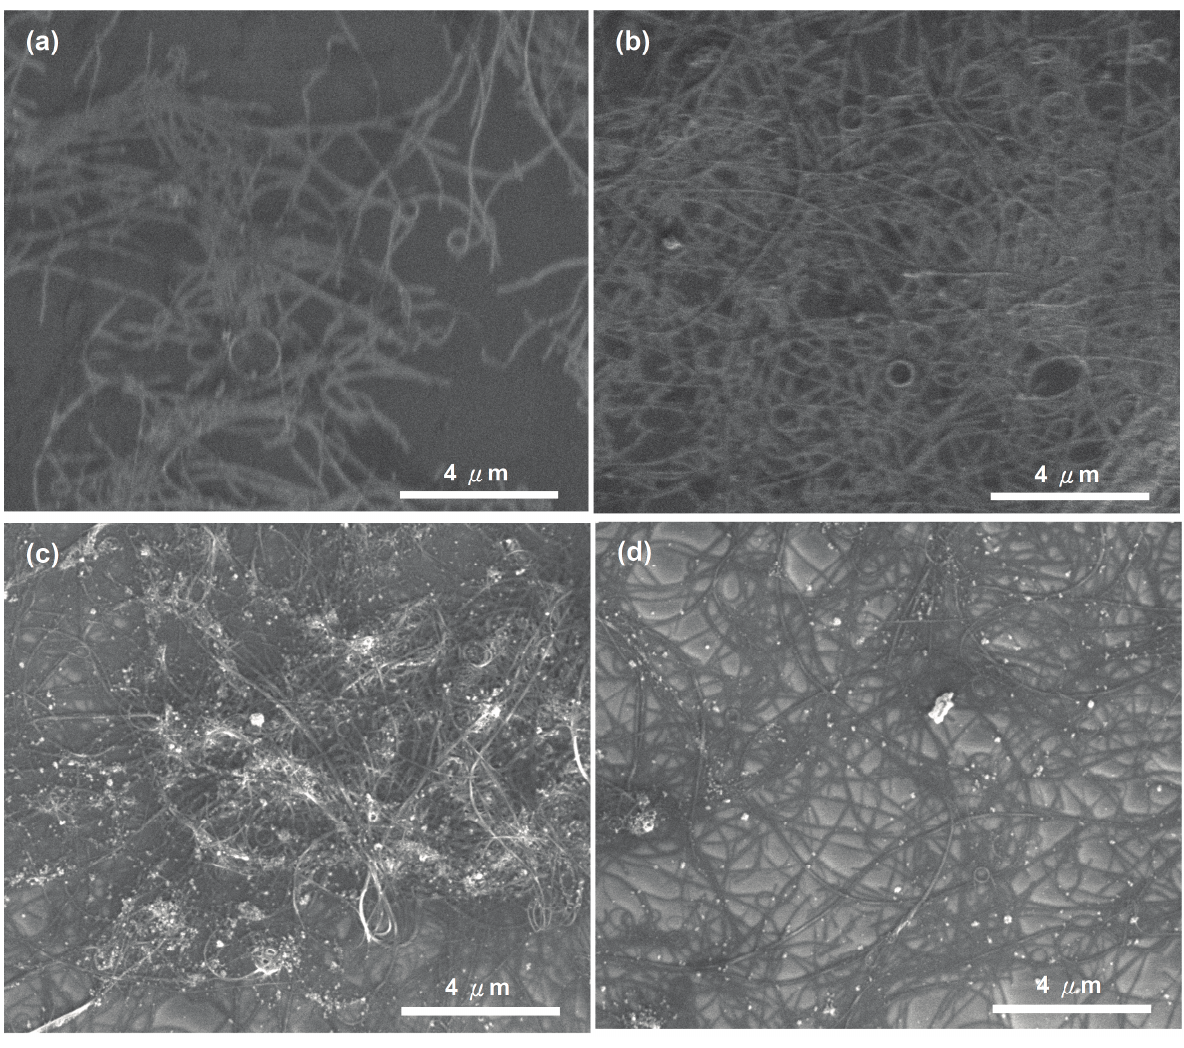
Figure 5. Scanning electron microscope-captured surface morphologies of ( a ) MWCNT; ( b ) MWCNT-polypeptide (13.0 wt%) composite films; ( c ) MWCNT-polypeptide (27.0 wt%) composite films; and ( d ) MWCNT-polypeptide (41.0 wt%) composite